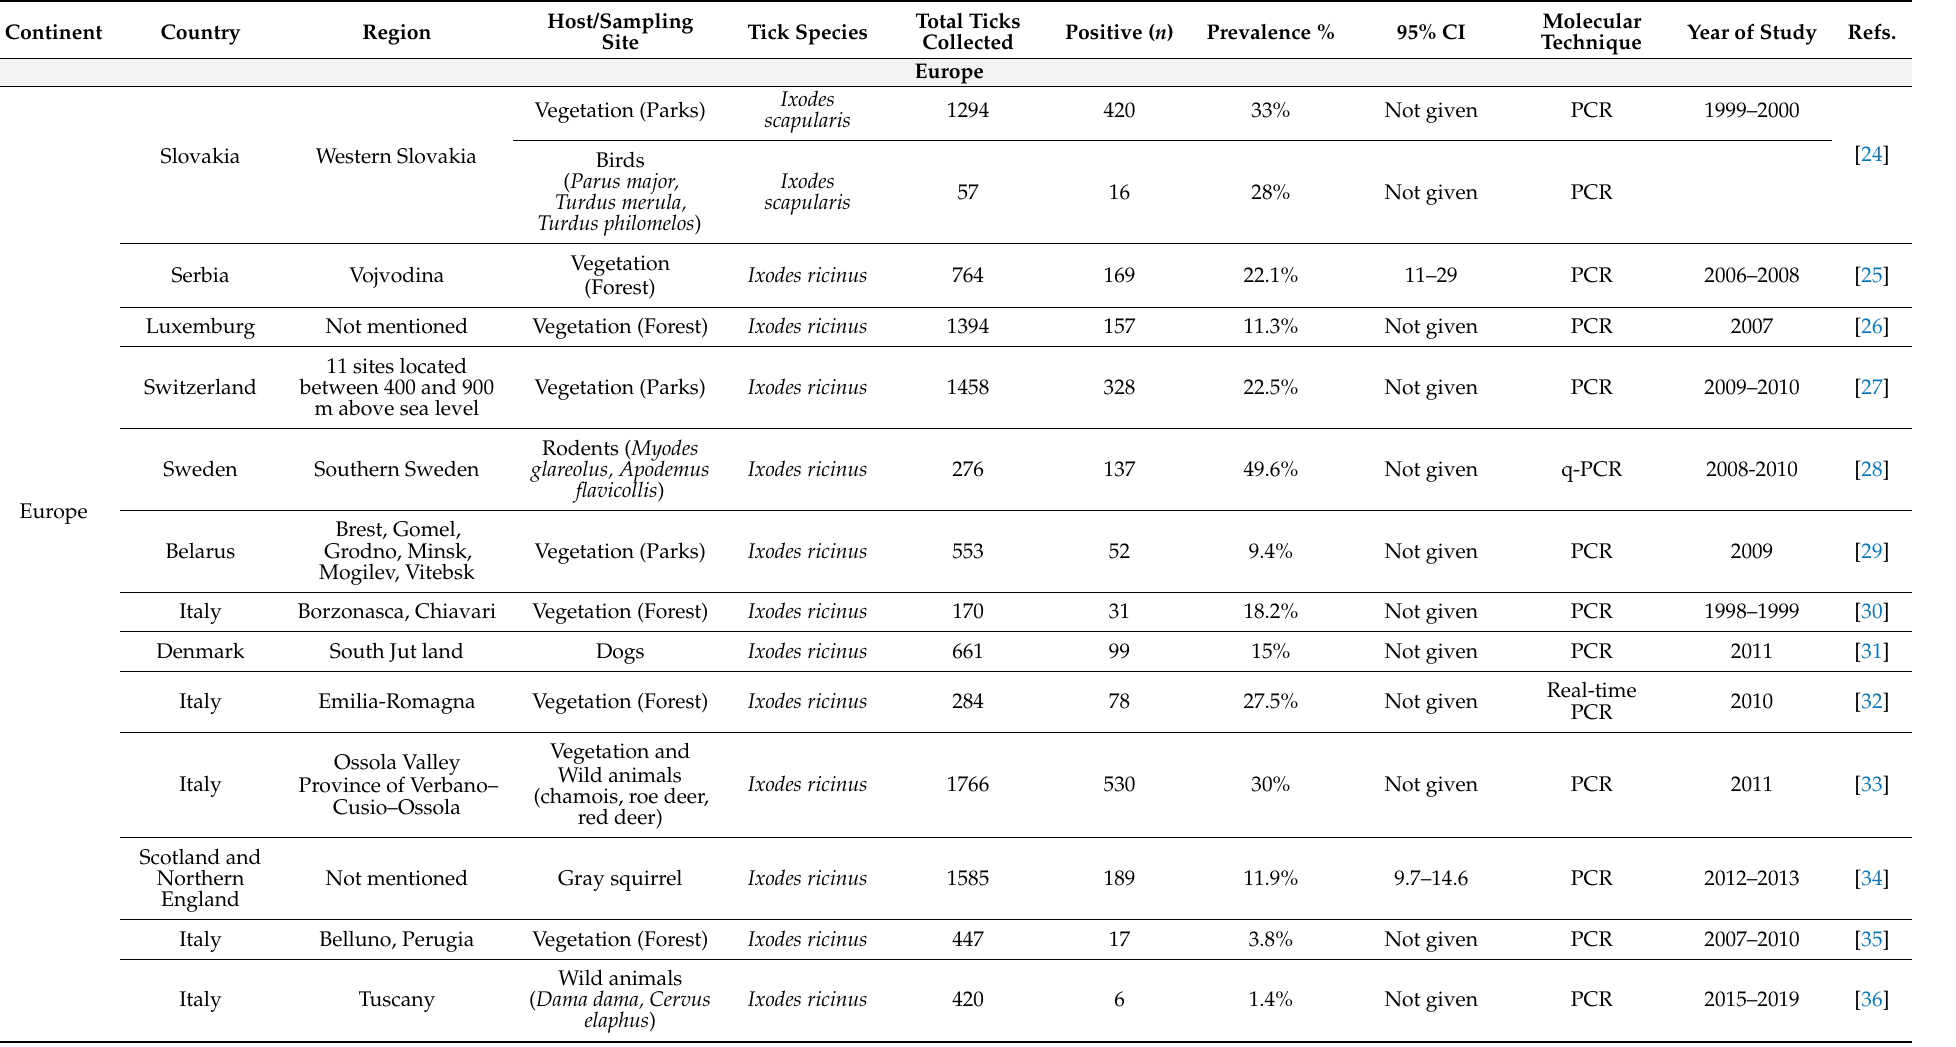
Table 1. Literature focusing on detection of Borrelia burgdorferi in ticks during the last two decades across the